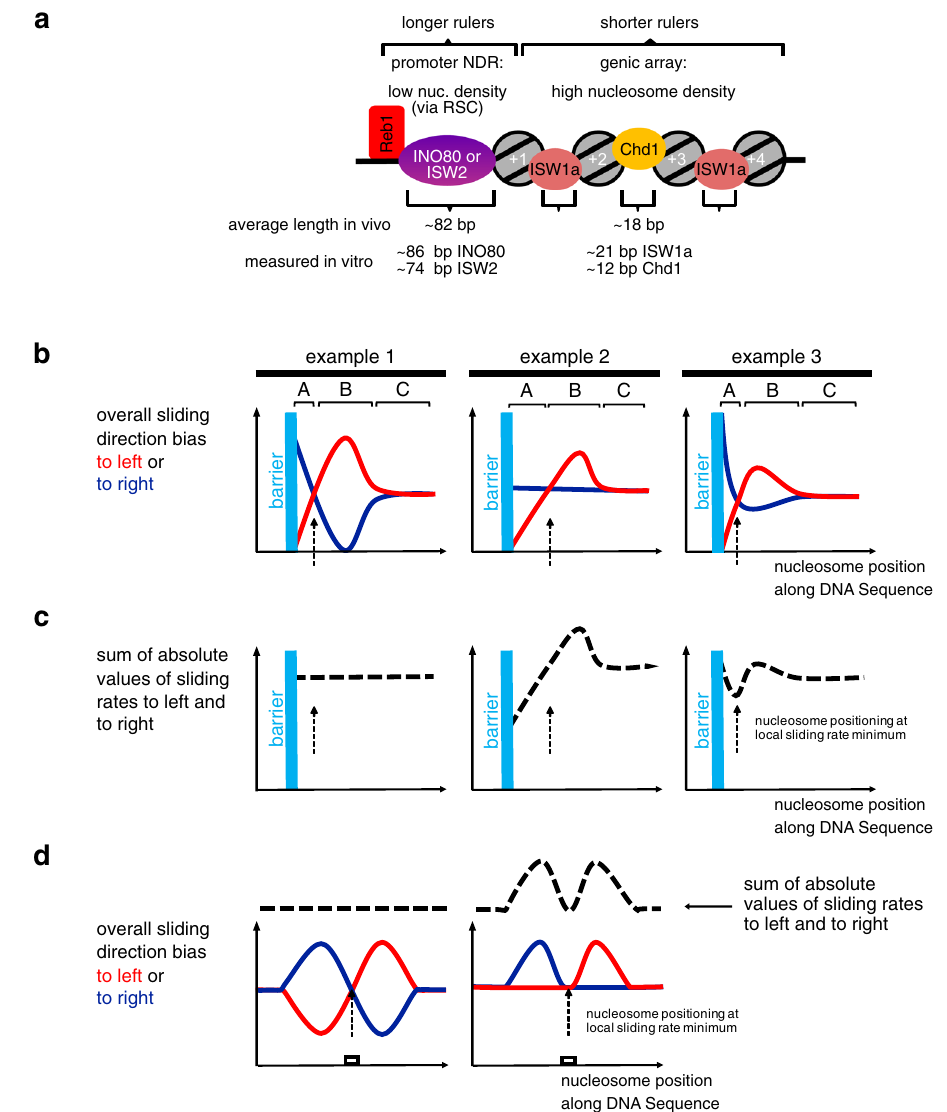
Fig. 7 Models for in vivo role of remodeler rulers and for ruler mechanism. a Schematic showing how different remodelers contribute to the stereotypical nucleosome organization at 5 ′ ends of genes in vivo. The promoter is a nucleosome-depleted region (NDR) with low nucleosome density, e.g., due to nucleosome eviction by RSC. The gene body is organized in densely packed and regular nucleosomal arrays. The in vivo observed average distance between the fl ank of the + 1 nucleosome and the center of a Reb1-binding site (distance to barrier) and the average linker length (spacing) mainly re fl ect the contribution to varying degrees of INO80 ’ s or ISW2 ’ s long ruler or of ISW1a ’ s or Chd1 ’ s short ruler elements, respectively, as determined in vitro for low or high nucleosome density, respectively, in our study. This explains the main trends, while variations in remodeler type, nucleosome density as well as transcription, replication, and epigenetic marks may further locally modulate nucleosome organization. b Three hypothetical examples for how a remodeler ruler regulates the overall bias of sliding a nucleosome to left (red curves) or to right (blue curves) resulting in nucleosome positioning (stippled vertical arrows) in the vicinity of a barrier. c As b , but plotting sum of absolute values of sliding rates to the left and to the right (stippled black curves). d Two hypothetical examples for how a remodeler ruler leads to nucleosome positioning over a DNA sequence element (white box). Symbolics as in b and c . For details see